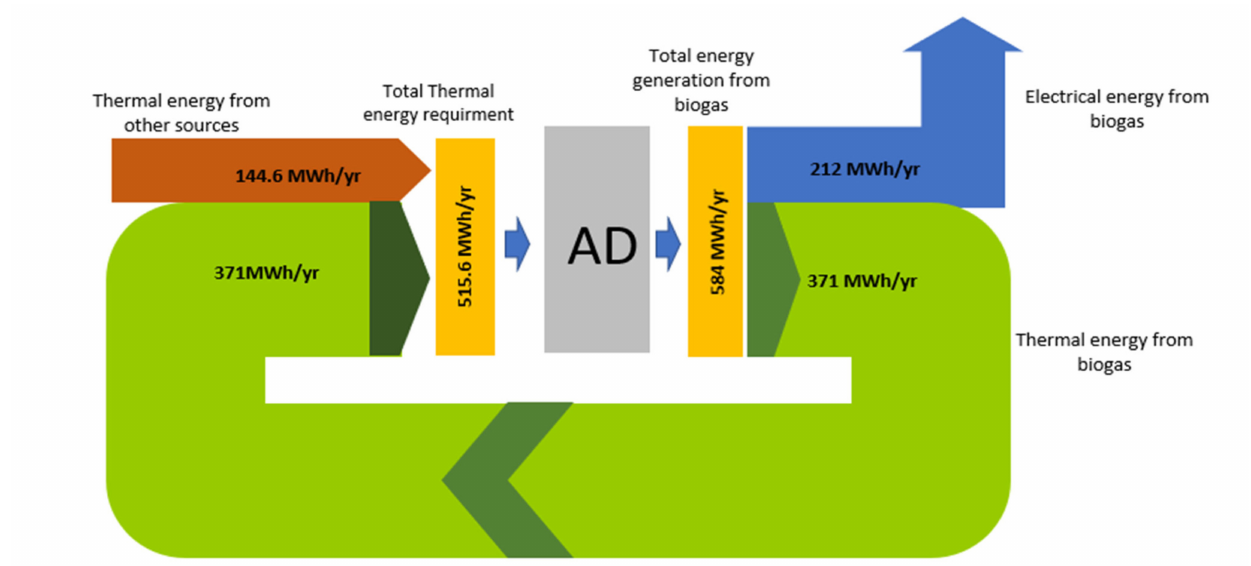
Figure 7. Sankey diagram of anaerobic digestion energy generation and